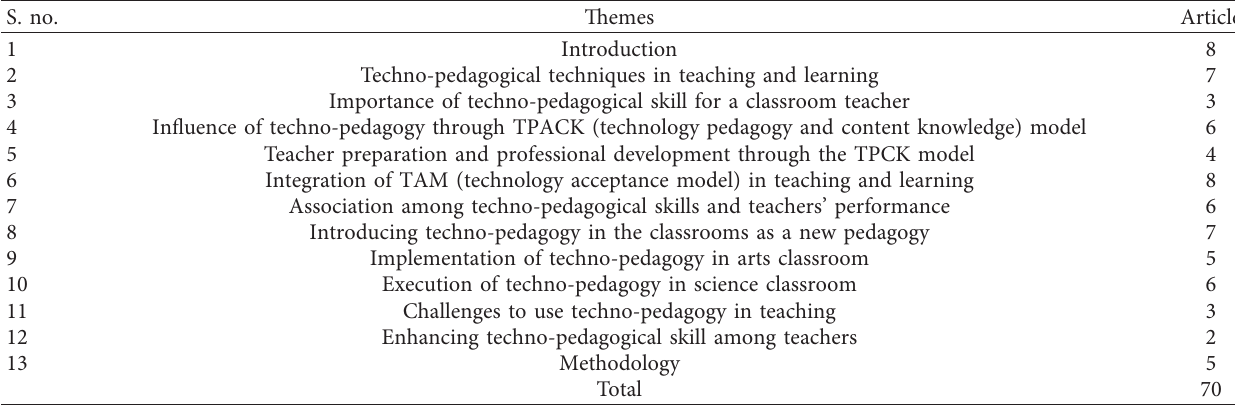
Table 2: Themes of literature review and number of